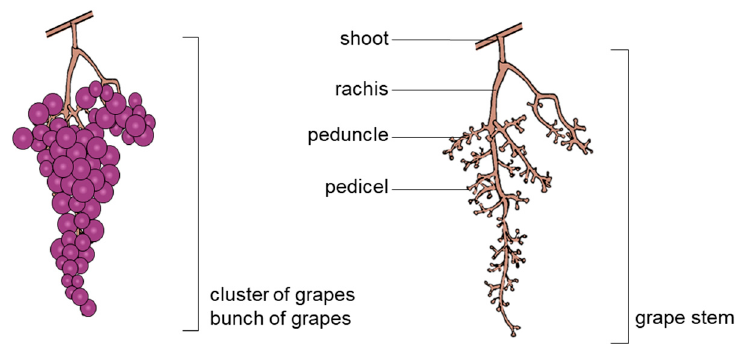
Figure 1. Bunch of grapes and stem morphology.